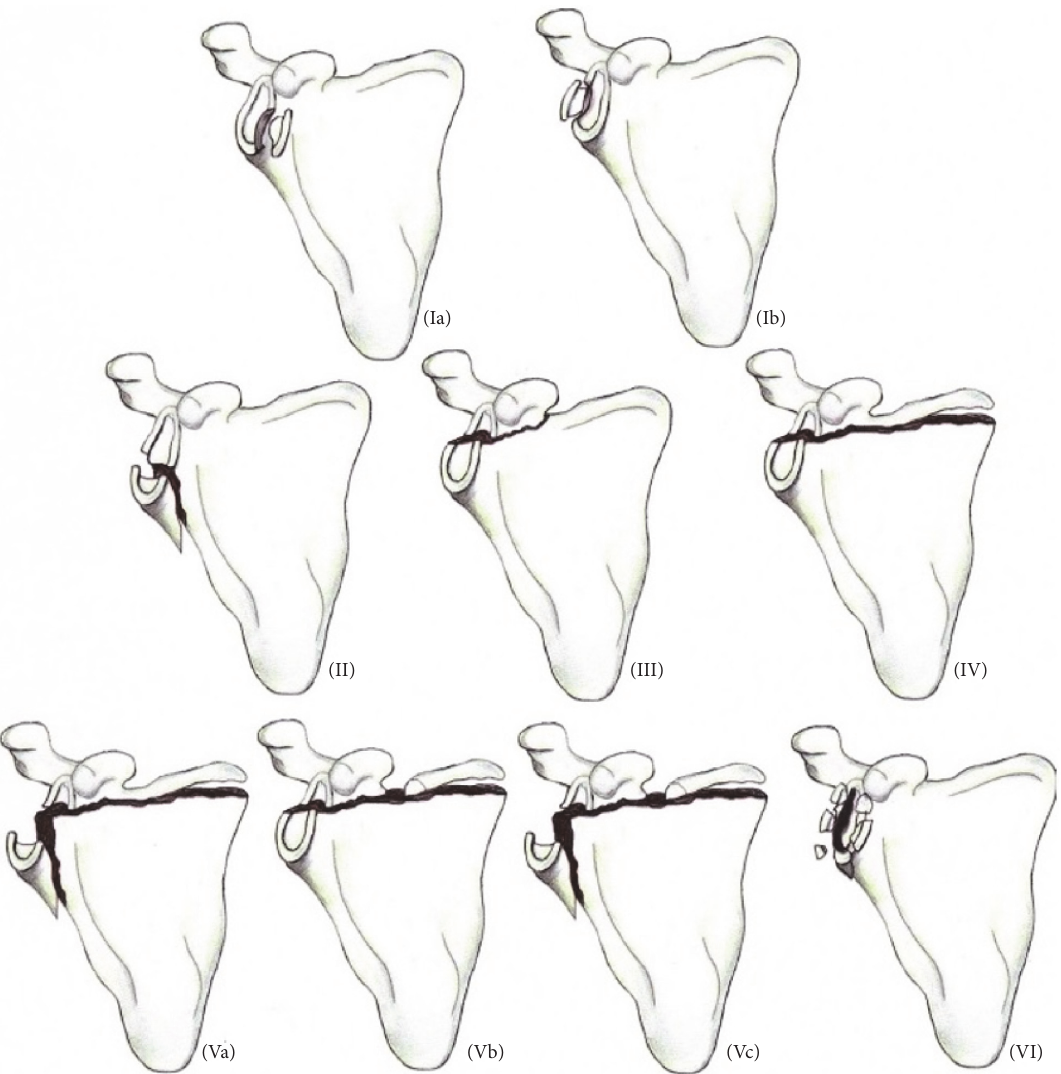
Figure 1: Ideberg